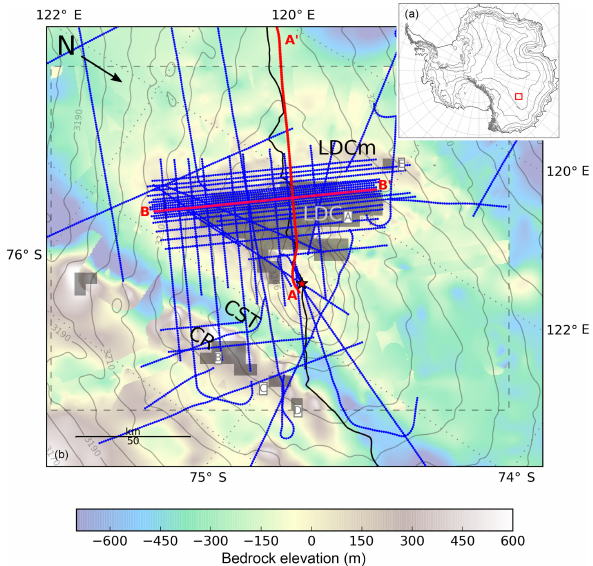
Figure 1. Map of Dome C and the surrounding region. A red square locates the study area on the inset. The radar lines used in the accu- mulation reconstructions are displayed as blue lines. Highlighted in red are the two radar lines shown in Fig. 2. Dark gray blocks labeled A–E are the Van Liefferinge and Pattyn (2013) candidate regions. F labels a 1.5 million-year-old ice new candidate site (see com- panion paper). The background is bedrock elevation in ma.s.l. and combines Bedmap2 bed elevations (Fretwell et al., 2013) as well as a recompilation based on the OIA radar bed elevations (Young et al., 2017) delimited by a dashed rectangle (elevation differences are particularly visible along the CR). Gray contours are Bamber et al. (2009) surface elevations, a black line locates the ice divide. A red star locates the EPICA Dome C ice core. LDC locates the gen- tle secondary surface dome, LDCM locates the Little Dome C mas- sif under the densest radar lines, CR locates the Concordia Ridge steep escarpment along the Concordia Subglacial Trench (CST).